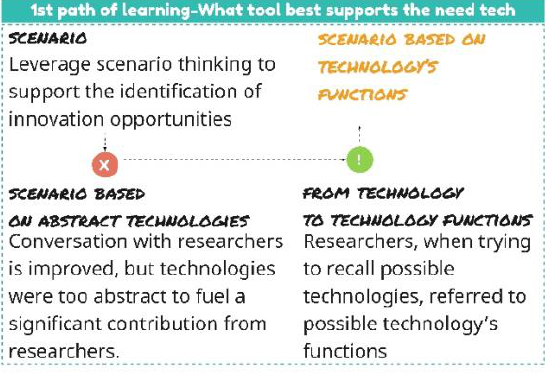
Fig. 11. What kind of scenario best supports the interaction between design teams and researchers to identify alternative technologies?